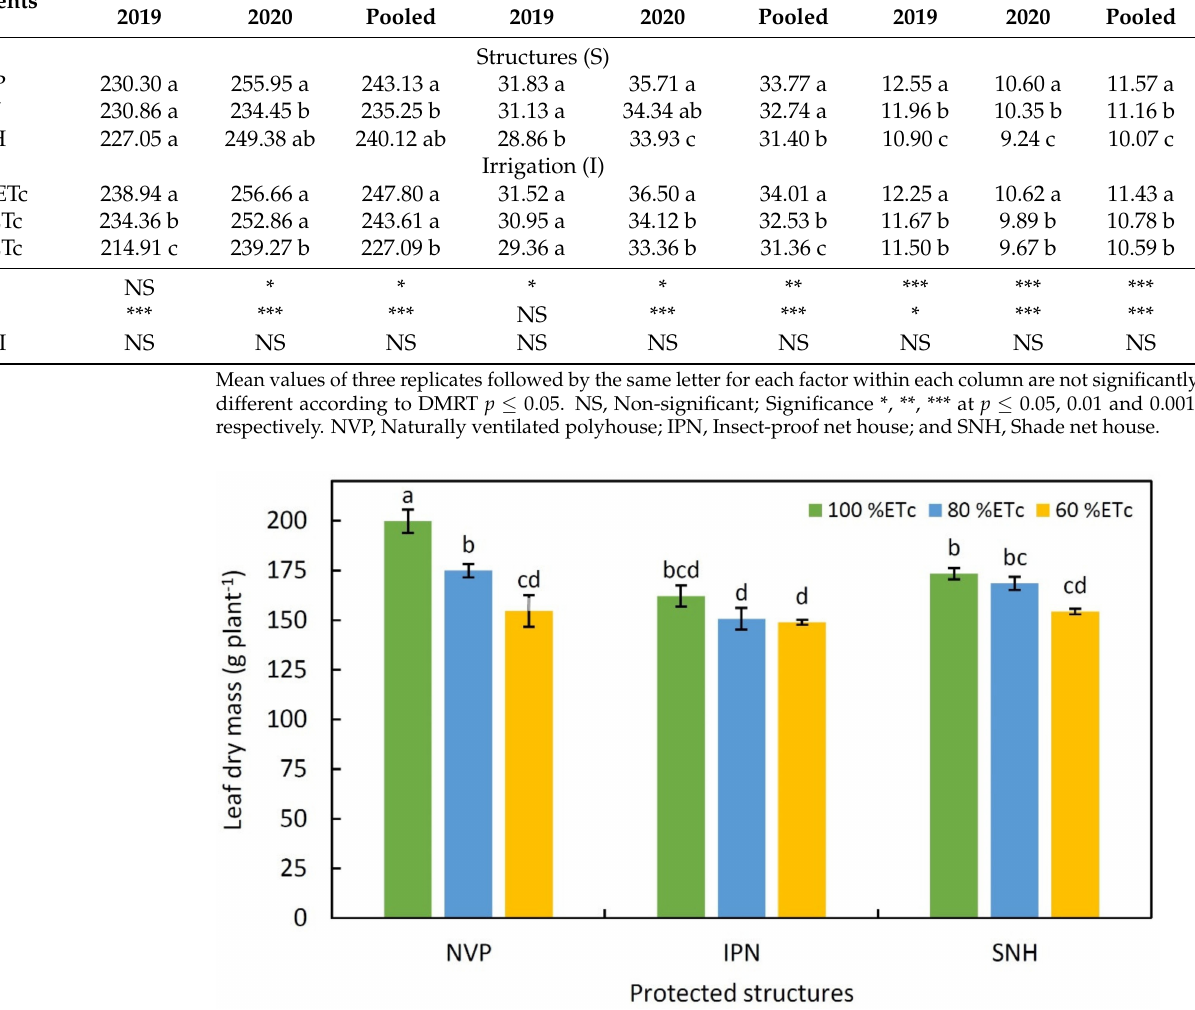
Figure 1. Leaf dry mass (g plant − 1 ) under different irrigation levels and protected environment structures. The values followed by the same letter are not significantly different at p ≤ 0.05 according to DMRT. Protected structures: NVP, Naturally ventilated polyhouse; IPN, Insect-proof net house; and SNH, Shade net